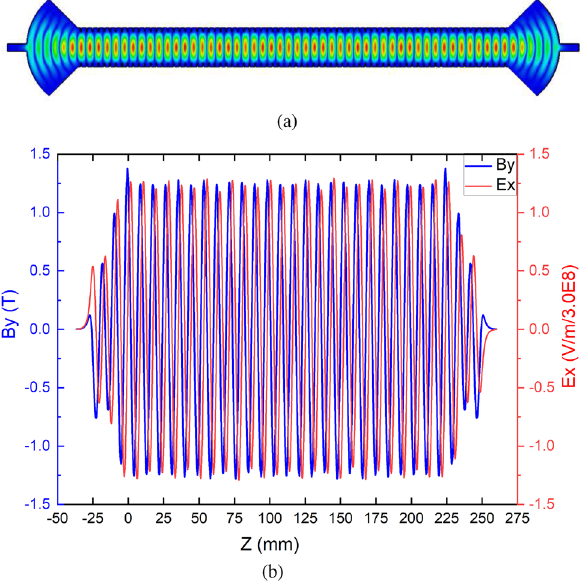
Figure 2. The electric field pattern of the MU cavity with 72 periods of regular corrugation sections ( a ), and the magnetic and electric fields on-axis ( b